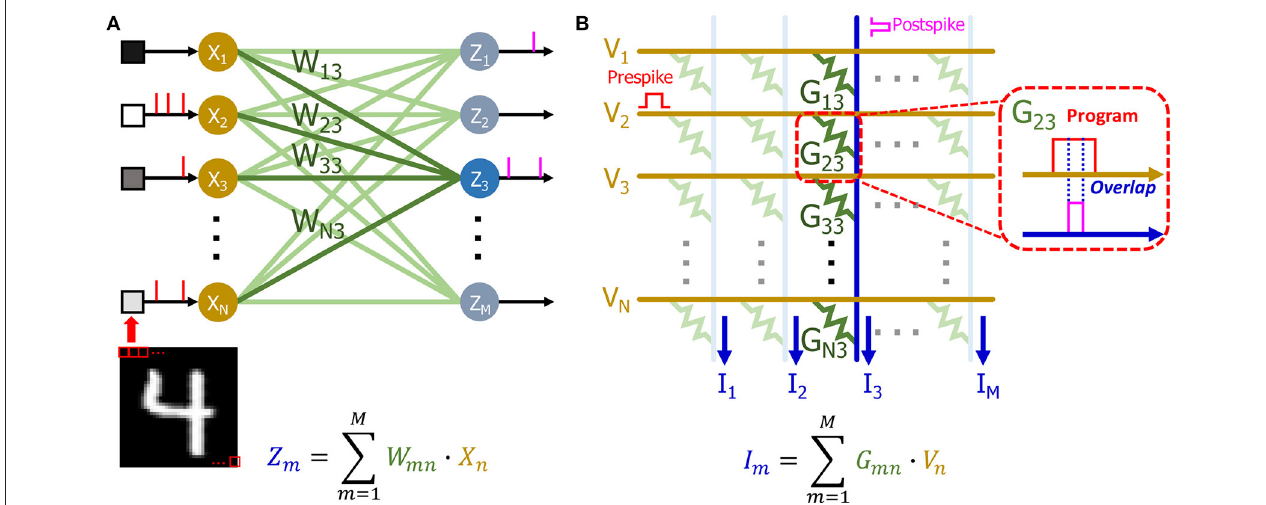
FIGURE 10 | (A) Schematic of SNN with n input neurons and m output neurons. The pixel intensities of input image are decoded into passion spiking training and fed to the input of the network. The weights ( W 13 , W 23 , …, W N 3 ) of output neuron Z 3 has been highlighted. (B) Schematic of a crossbar array based on eNVM devices. The input of (A) can be mapped to the voltage. The weights ( W 13 , W 23 , …, W N 3 ) are mapped to the conductance ( G 13 , G 23 , …, G N 3 ) of the devices. The weighted sum can be obtained by measuring the current at the end of each column. The postspike pulses are generated based on the weighted sums ( I ). The overlap of pre and post spike pulses as shown in callout window programs the device to different conductance states.